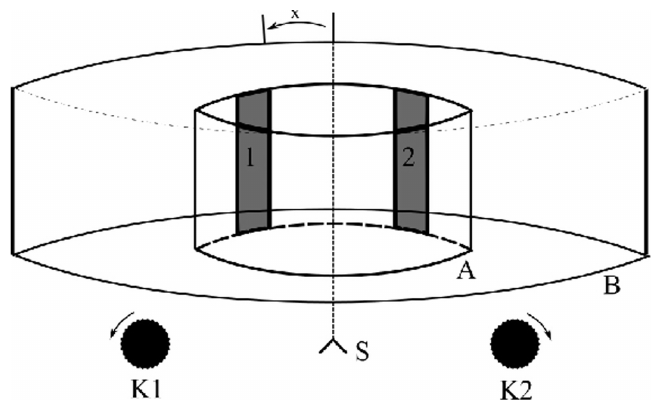
Figure 6: Two rotating hole experiment (side view). The two planar screens A Figure 2. Two rotating hole experiment (side view). The two planar screens A and are here replaced and are here replaced by cylinders. The position of each of the two holes 1 and by cylinders. The position of each of the two holes 1 and 2 can be rotated with a knob ( K 1 and K 2 , respectively) and each knob can move the respective hole around the entire cylinder A 26